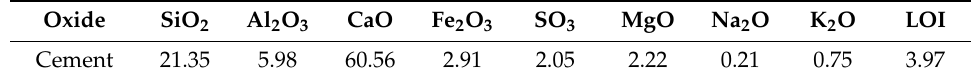
Table 1. Chemical compositions of cement.